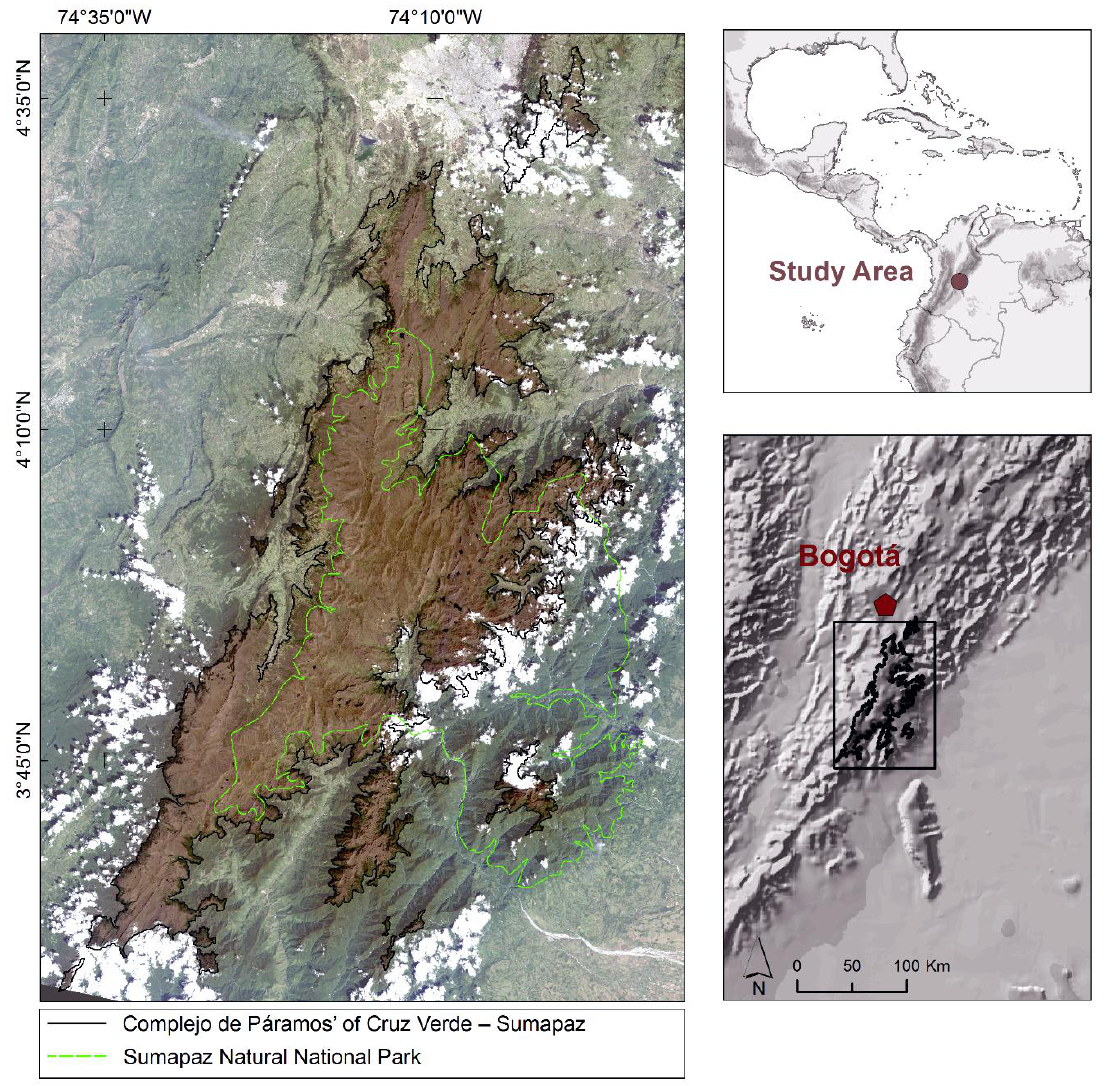
Figure 1. Study area. “ Complejo de Páramos ” of Cruz Verde-Sumapaz in the Colombian Andes mountains (background map: Landsat 8 true colour composite) [23]. The dashed green line indicates the Sumapaz National Park